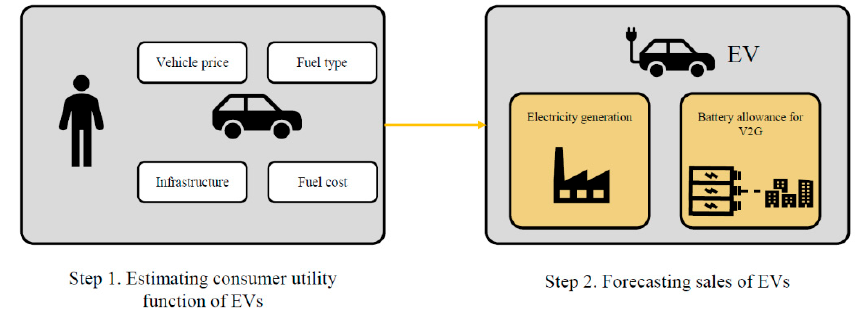
Figure 1. The framework of this study.